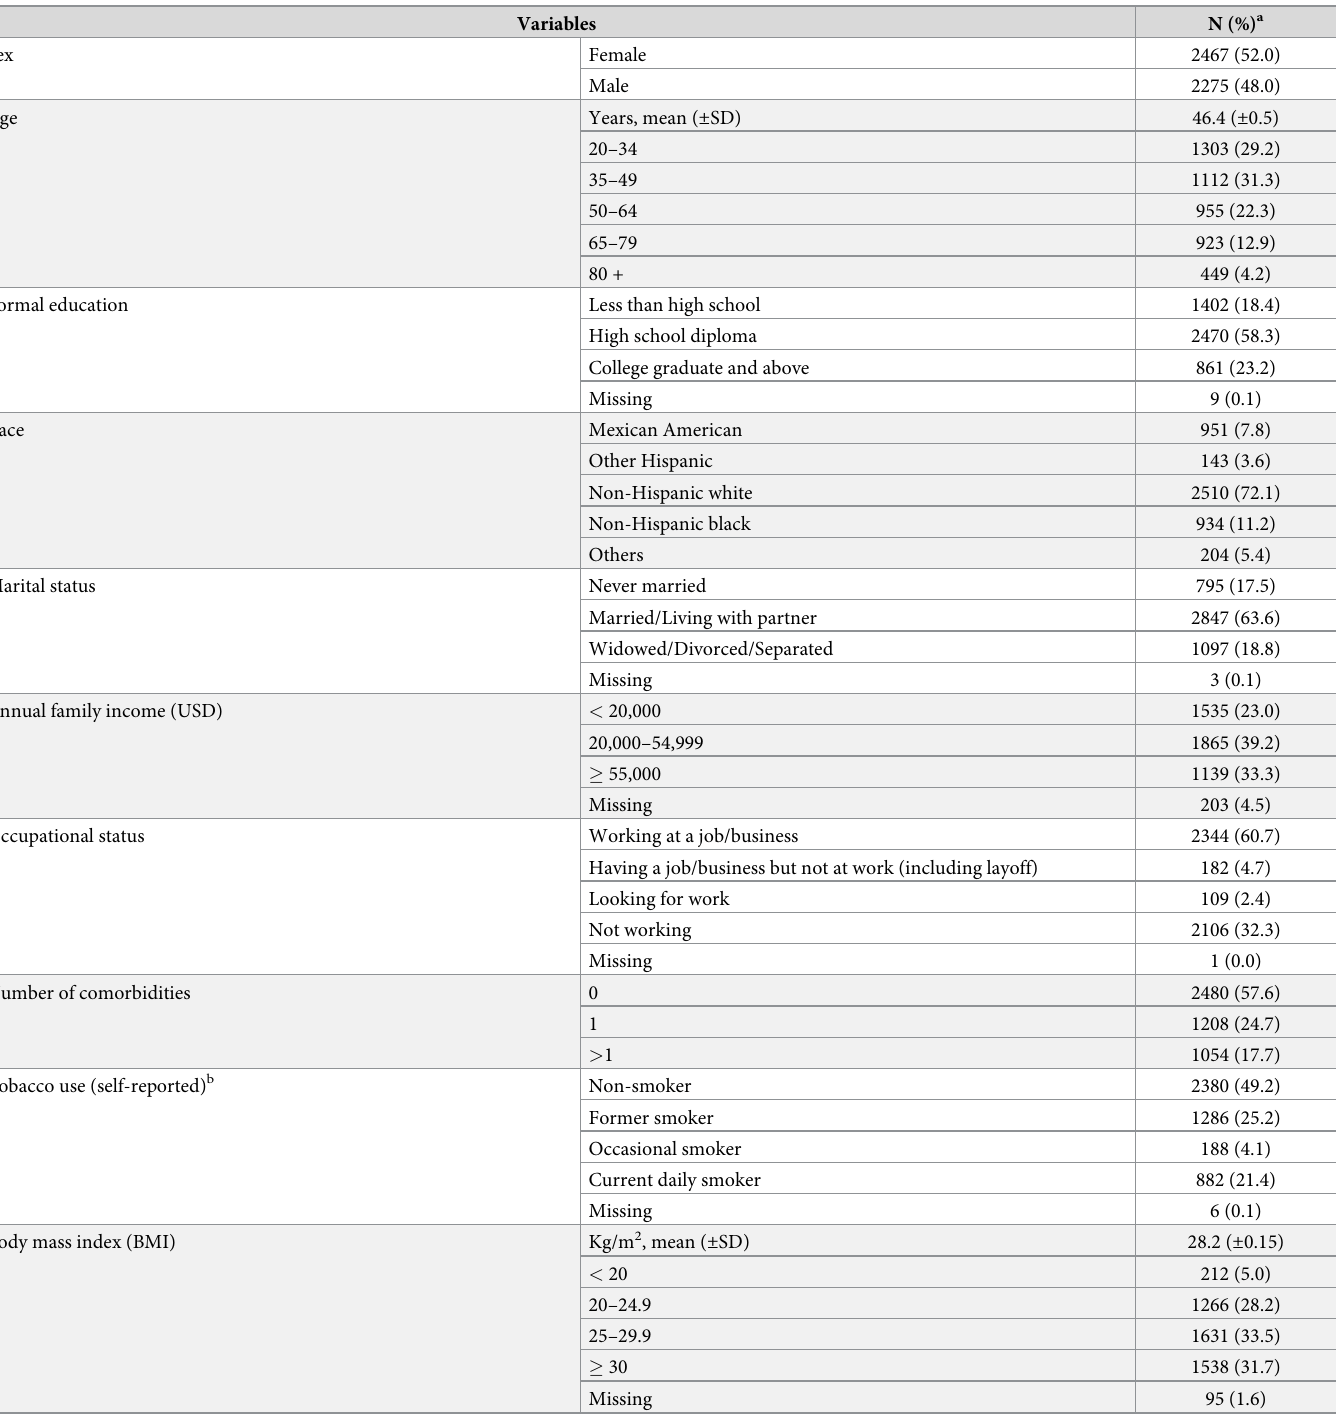
Table 1. Selected characteristics of the study sample (n =